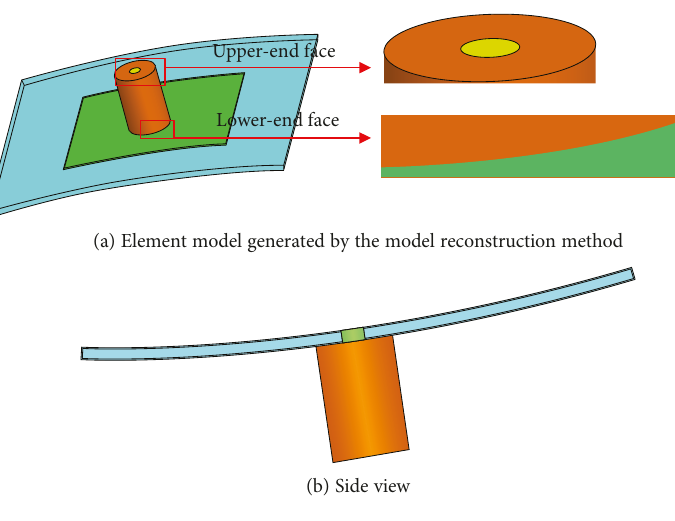
Figure 10: Antenna element model generated by the model reconstruction method.